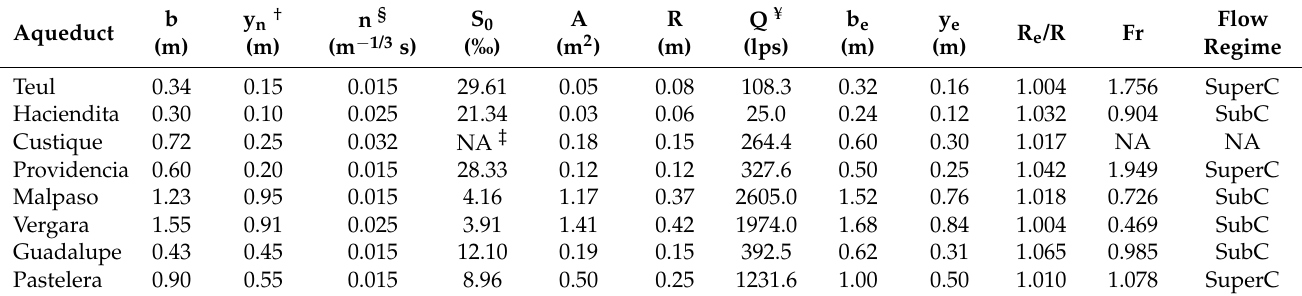
Table 1. Hydraulic properties and flow rate in eight olden